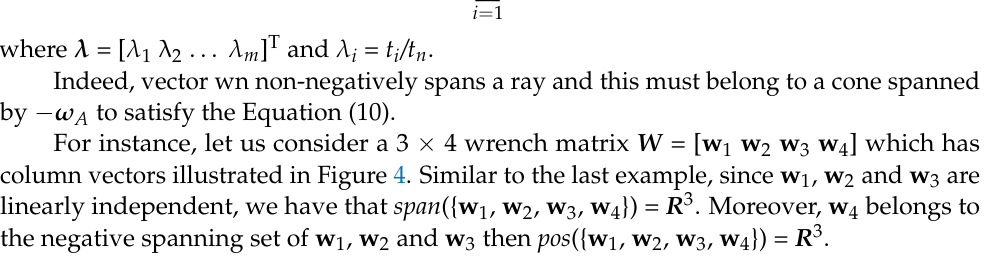
Figure 4. Specific case of a certain 1-redundant actuator-planar CDPM when general coordinates of moving platform are presented in the wrench-closure workspace. 4. Simplify Problem by Using Linear Equivalence Let M ∈ R mxm be the square matrix established by taking m-column vectors in W and H ∈ R mx(n-m) consist of the remaining column vectors in W . According to Theorem 1, if x ∈ WCW ⊂ R m then ω must contain m linearly independent vectors, i.e., there exist a certain set of m-column vectors in W that form the nonsingular matrix M .